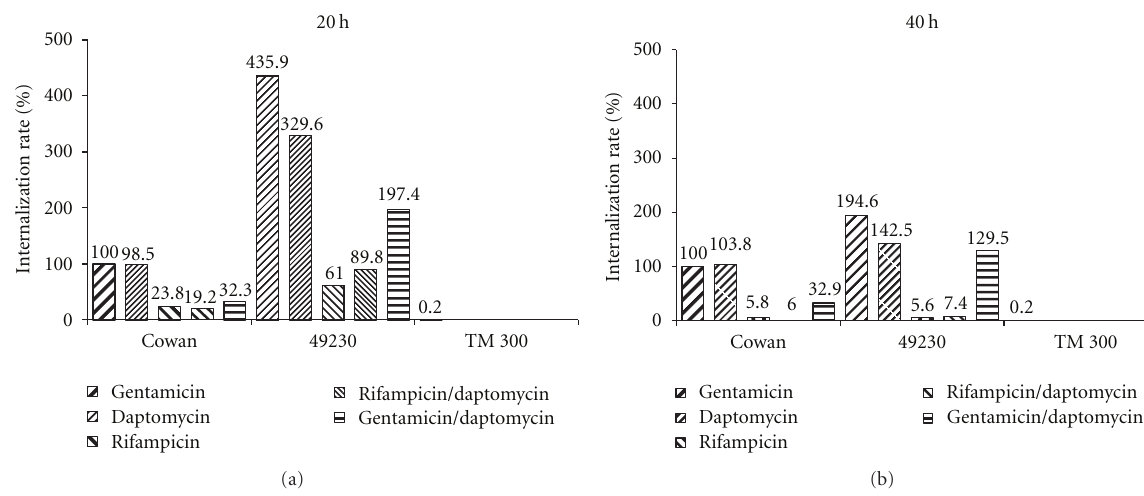
Figure 4: In vitro infection model—internalization rate for 20 h and 40 h of 3 di ff erent. Staphylococcus strains with application of di ff erent antibiotics. Invasiveness of Cowan with gentamicin set at 100%. TM 300 served as a negative control group.